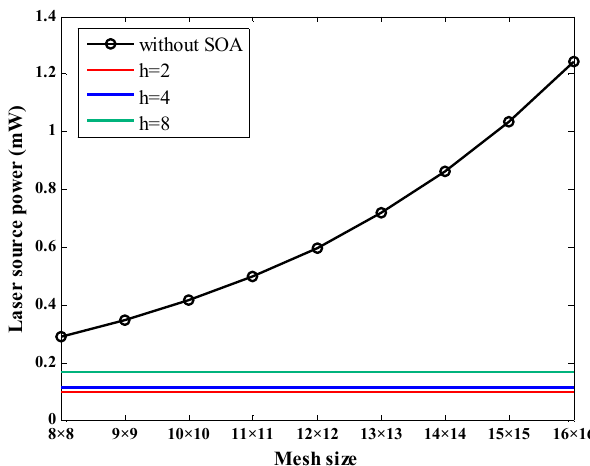
Figure 15. Laser source power comparison between a conventional HONoC (without SOA) and SOA-enabled HONoC.